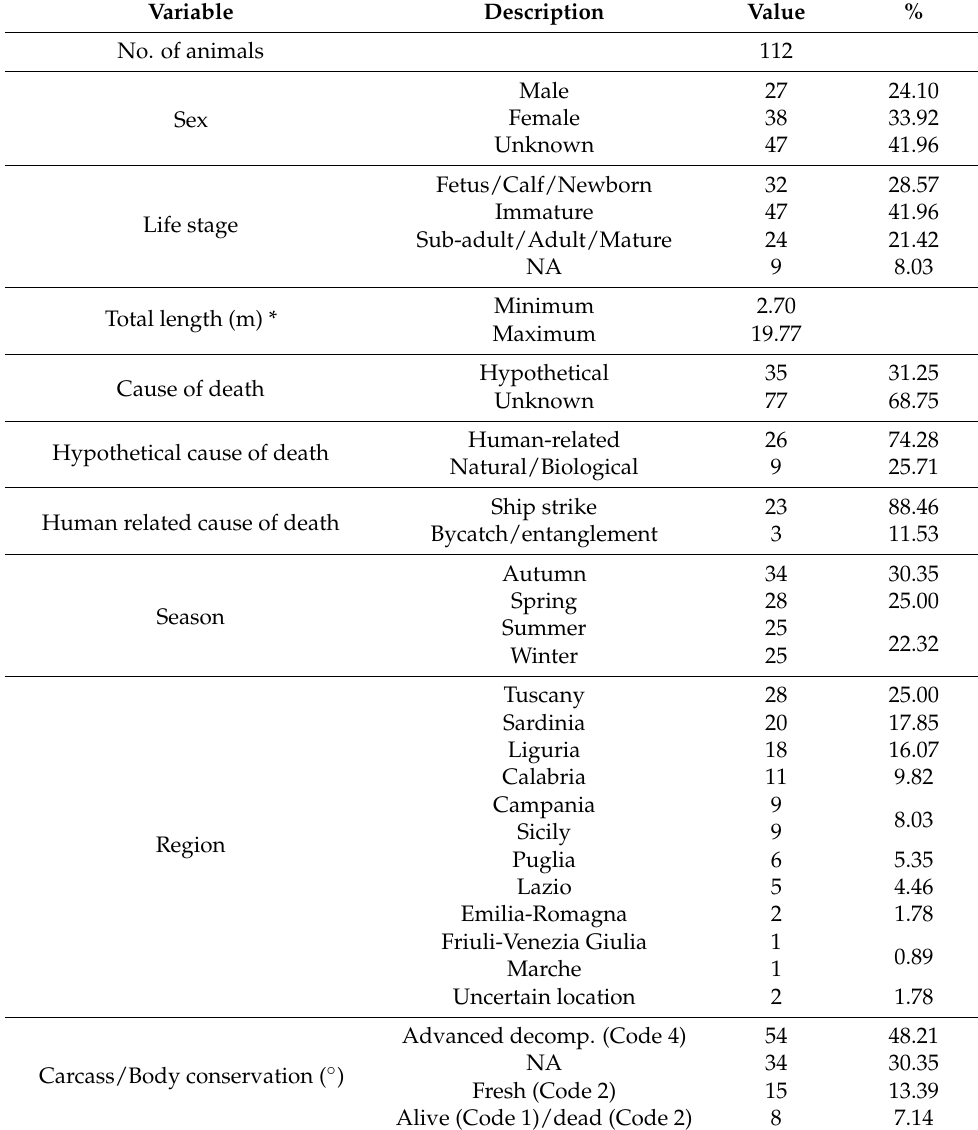
Table 2. Summary of the main variables of modern mortality events (1964–2021). NA Not available, (*) Estimated and measured lengths, ( ◦ ) One animal was Code 5 (Mummified/Bones).